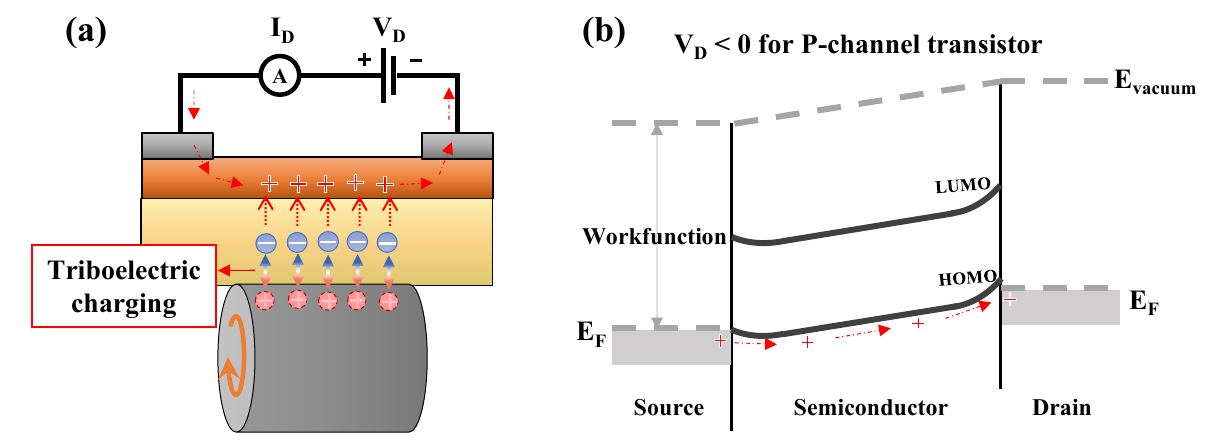
Figure 5. ( a ) Working mechanism of the fabricated RGT and ( b ) the energy level diagram along the channel of a p-channel transistor showing the transport of hole carriers from the source through the semiconductor to the drain. The orange arrow indicates the rotation of the gate, the circular plus (+) and minus ( − ) signs are positively and negatively charged triboelectric charges, respectively. The hole carriers indicated by plus signs induced from the negative charges flow along the dotted arrow and contribute to the I D . The work function of Ag used as the electrodes is 4.74 eV, which is adjacent to the highest occupied molecular orbital (HOMO) of P3HT, and the energy difference from the lowest unoccupied molecular orbital (LUMO) is large; thus, electrons are blocked [37,42,43]. Figure 6 shows the I D on/off ratio ( ∆ I D ) of transistors fabricated using the conventional FET structure and the fabricated RGTs. The transistor in Figure 6a was fabricated using the same method used to fabricate the RGT, but instead of the rotating Al gate in contact with the dielectric, a V G from 0 to –30 V was applied to the Al gate electrode deposited with a thickness of 40 nm under the PTFE layer. The FET structured transistor exhibited a remarkably low ∆ I D even when a voltage of –30 V was applied to the gate (Figure 6a). As explained, this transistor was not expected to exhibit a field effect because PTFE was used as the dielectric layer, which restricts the formation of an internal electric field. In contrast, the I D of the fabricated RGT increased with an increase in the rotational velocity of the gate and the thickness of the dielectric layer (Figure 6b,c). However, devices with a dielectric layer thickness of 0.3 and 0.5 mm showed lower ∆ I D in drop-casted devices with thicker channer layers than spin-coated devices. This is because a thicker channel layer with higher trap density results in an increase in the off-state I D ( I Off ) as expressed in the equation below [36]: